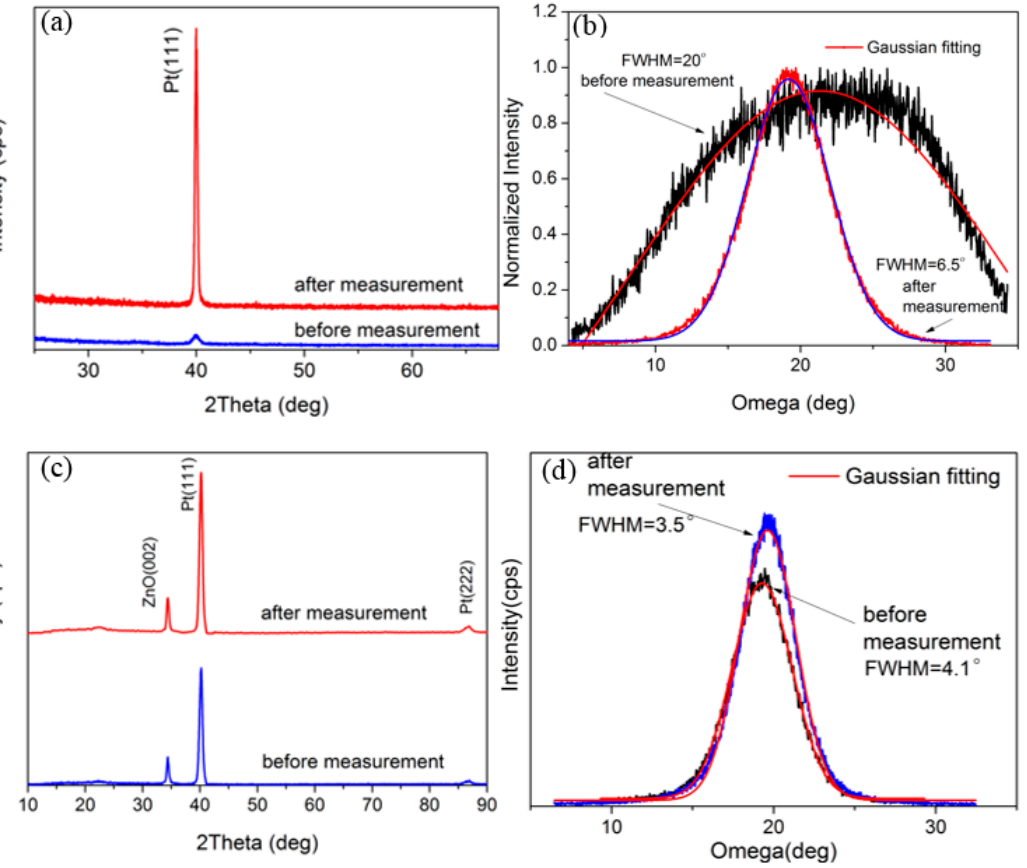
Figure 6. ( a ) θ –2 θ scan; and ( b ) rocking curves of the AlN/Pt/ZnO(RT)/LGS samples before and after 1000 °C resistance measurement; ( c ) θ –2 θ scan; and ( d ) rocking curves of the AlN/Pt/ZnO(600 °C)/LGS samples before and after 1000 °C resistance measurement.